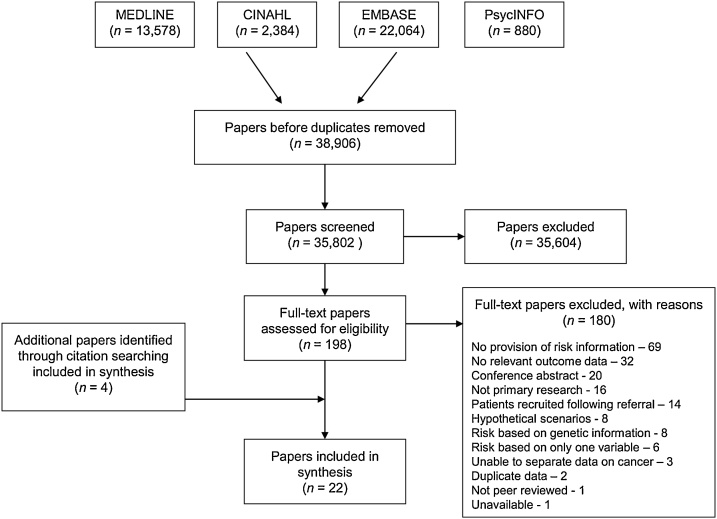
PRISMA Flow diagram.